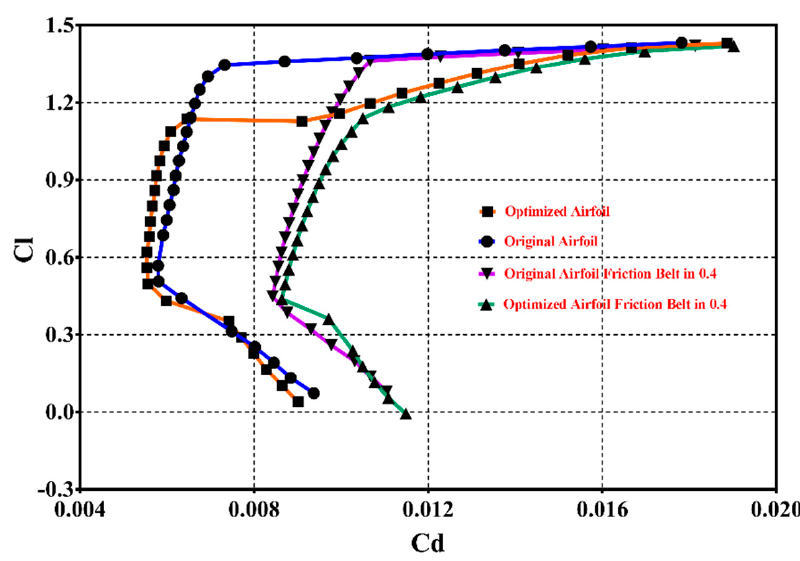
Figure 11. Comparison of aerodynamic performance after normal optimization.